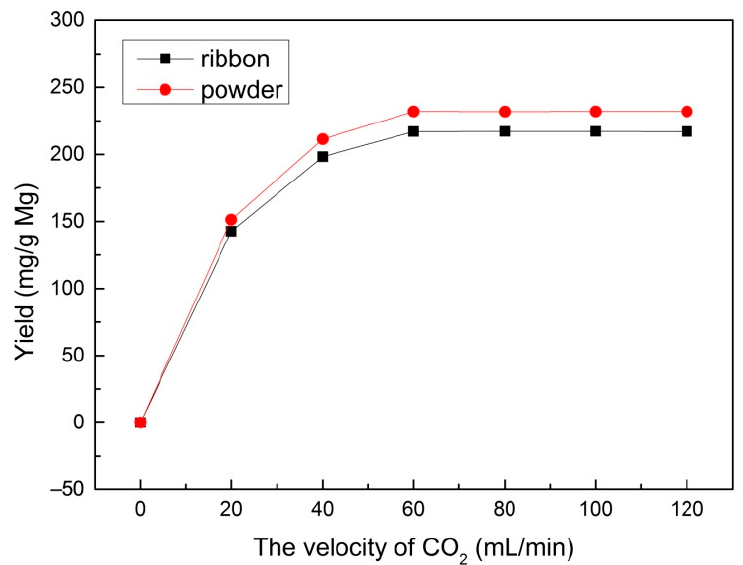
Figure 2. The yield under different velocities of CO 2 prepared with an Mg ribbon and Mg powder. According to Equation (1), 3 g Mg can react with 6.17 × 10 mol CO 2 (51.03 mL / min of CO 2 for 30 min, according to Equation (3)). Therefore, the amount of CO 2 is not enough to react with metal